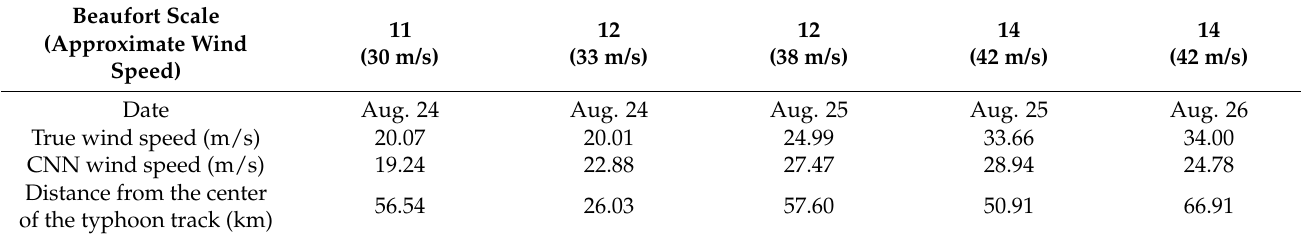
Table 4. Comparison results of wind speed data from Department of Water Resources of Zhejiang Province. Beaufort